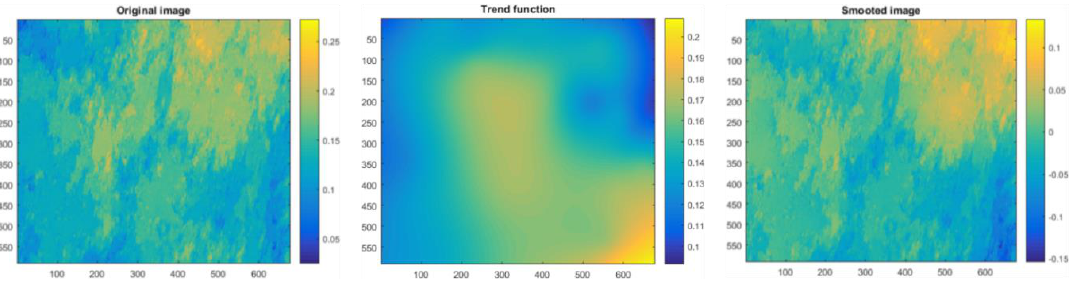
Figure 5. An example of trend removal for the descending orbit, displacements between 2nd and 8th of January 2017: Original data ( left ), trend function ( middle ), and smoothed data ( right ). The example is the local (image) coordinate system; deformation values in [m]. Please note different deformation scales in the original and smoothed images.